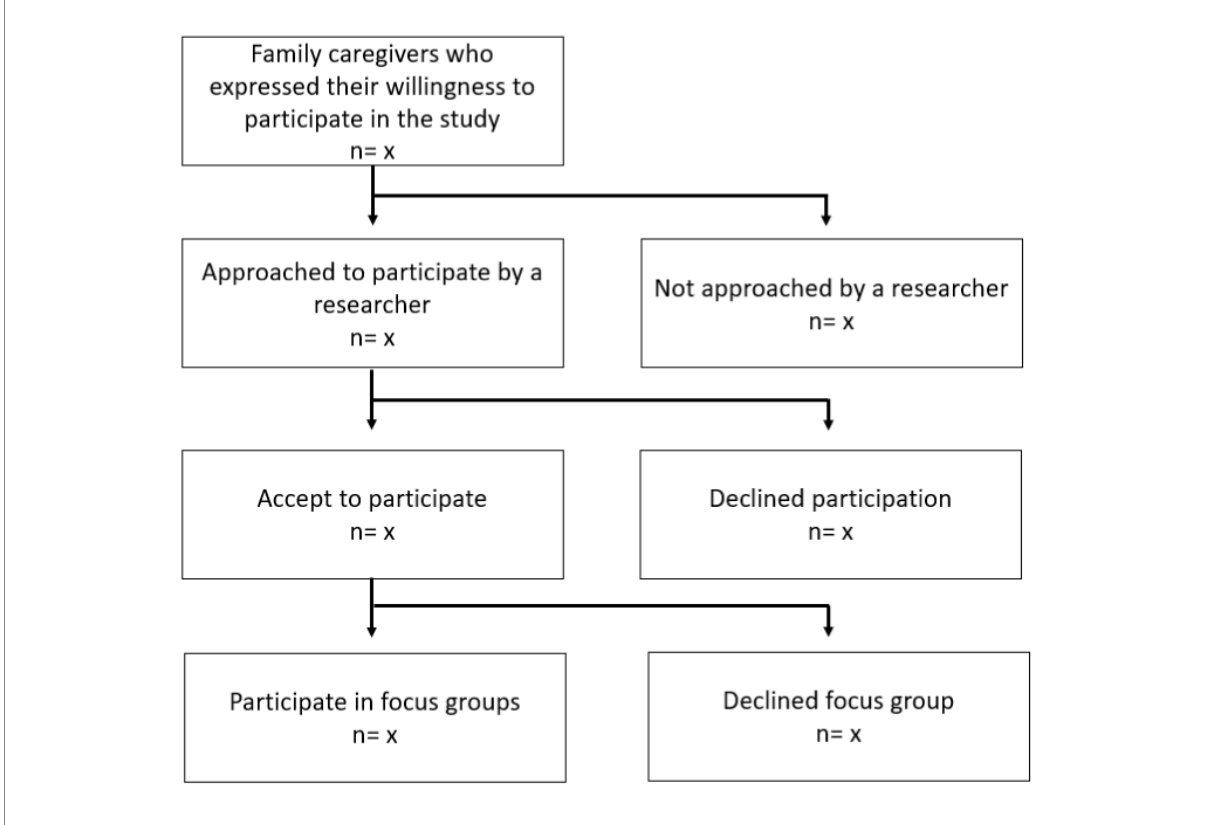
FIGURE 2 Study participant flow